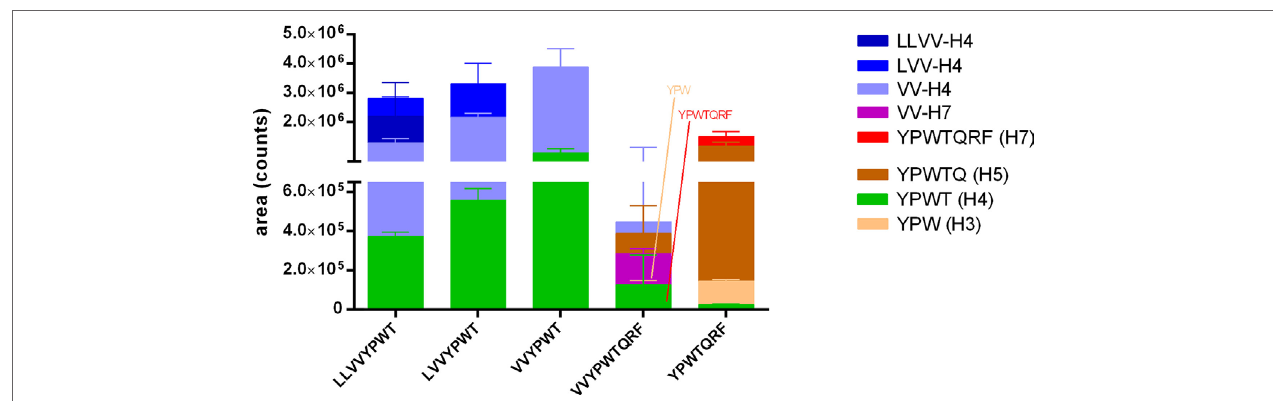
FigUre 4 | Passage of the five hemorphins intact or their fragments across the brain-like endothelial cell blood–brain barrier (BLEC) model. The passage of the five hemorphins was tested in the BLEC model (co-culture of hematopoietic CD34 + -derived endothelial cells with bovine pericytes). Each peptide was separately applied at 100 µM in the apical chamber (“blood” side) of a transwell and the presence of the intact peptides and potential fragments thereof in the basal chamber (“brain” side) was investigated by a combination of LC-MS/MS with multiple reaction monitoring (MRM) and pseudo-MRM analyses after 30 min incubation. Data are expressed as mean ± SD ( n =